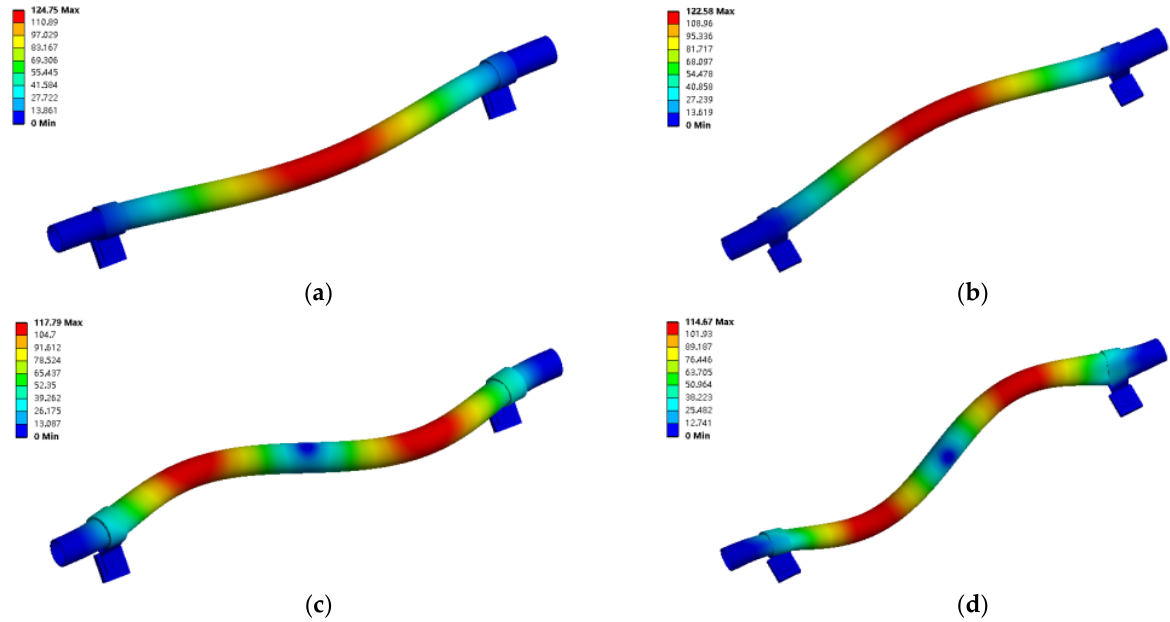
Figure 7. Vibration shape diagram of the galvanized steel clamp-piping system. ( a ) Level 1; ( b ) Level 2; ( c ) Level 3; ( d ) Level 4.